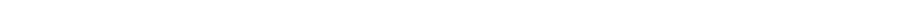
figure on next Fig. 9 a SEM image of a representative NR-FET with the source (S), drain (D), and gate (G) electrodes labelled in it comprising of ten NRs as active layer. b Photograph of flexible NR-FETs on PI substrate wrapped on a curved surface. c Transfer characteristics (experimental (line) versus model (dashed) simulations) and ( d ) output characteristics of the NR-FET at planar, tensile, and compressive bending conditions (Rc of the drain current at planar condition after cycles of compressive and tensile bending at V DS gate voltage after subjecting it to cyclic bending. g Breakdown voltage characteristics of four randomly chosen devices after subjecting to cyclic bending of 100 cycles. Reproduced with permission from